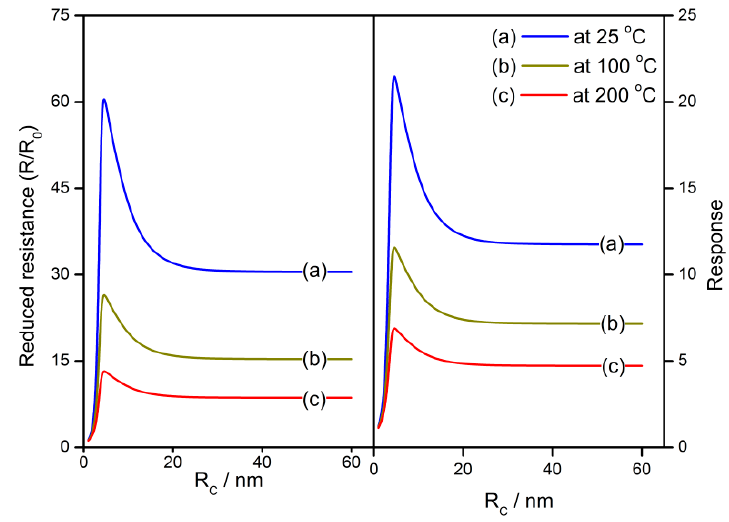
Figure 14. The grain size effects of reduced resistance and response at various operating temperatures of 25–200 °C.